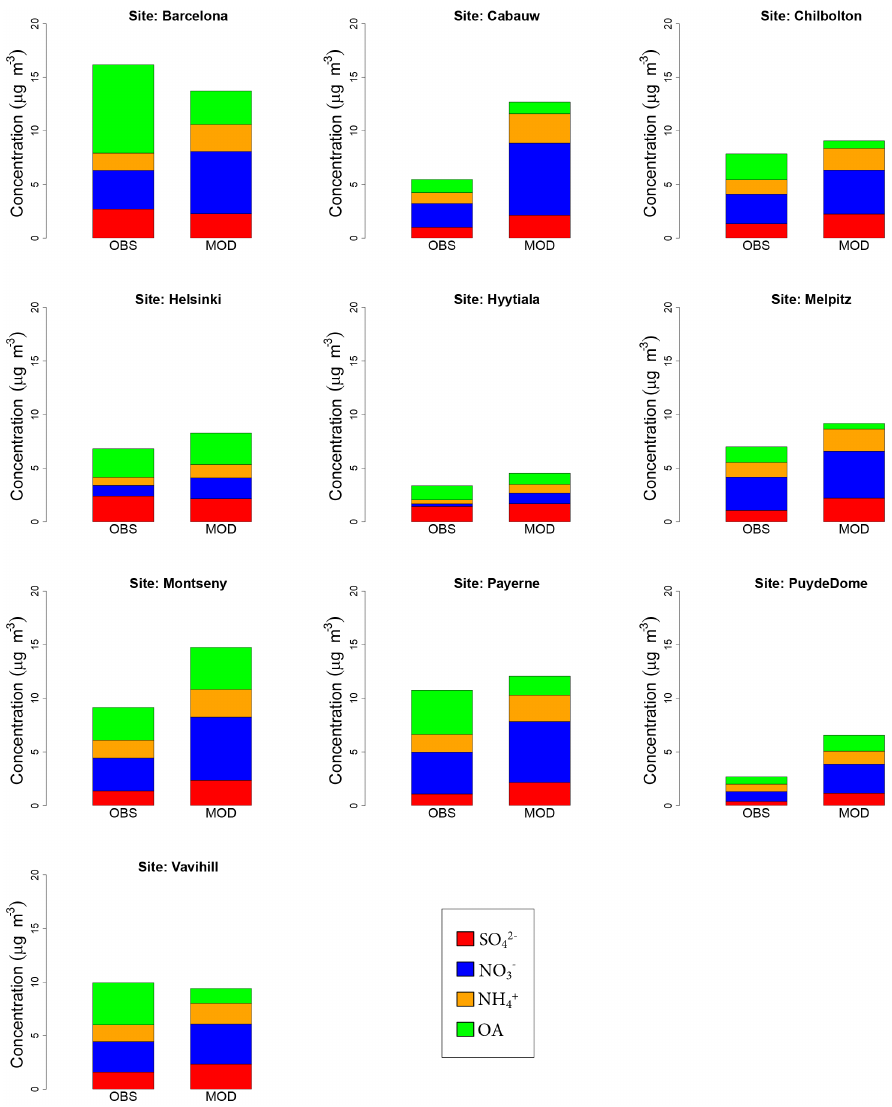
Figure 3. Comparison of observed (OBS) non-refractory PM 1 and modelled (MOD) non-refractory PM 2 . 5 at 10 AMS sites in Europe during February–March 2009. Mace Head is reported only in Table 3 since the ammonium component is not